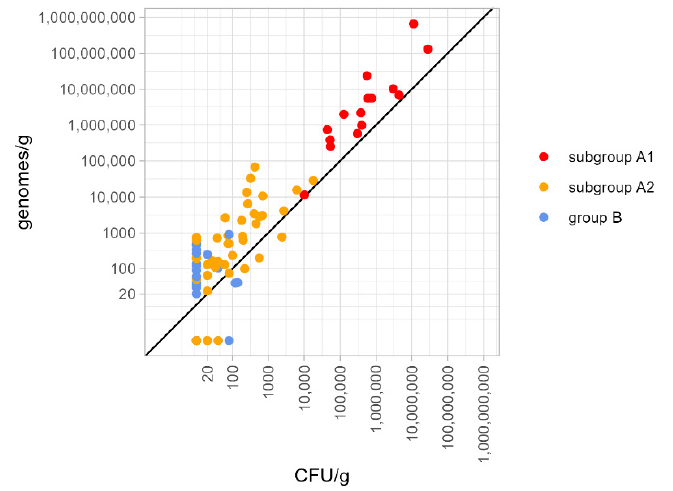
Figure 2. Microbiological and qPCR test results of powdered sugar samples grouped by history of AFB’s presence in subgroups A1, A2, and B. The diagonal line represents equal counts by the two tests. Table 2. Distribution of results obtained by microbiological and qPCR assays according to the dif- ferent classes of contamination level expressed in terms of the CFU/g or spore/g of P. larvae , respec- tively.